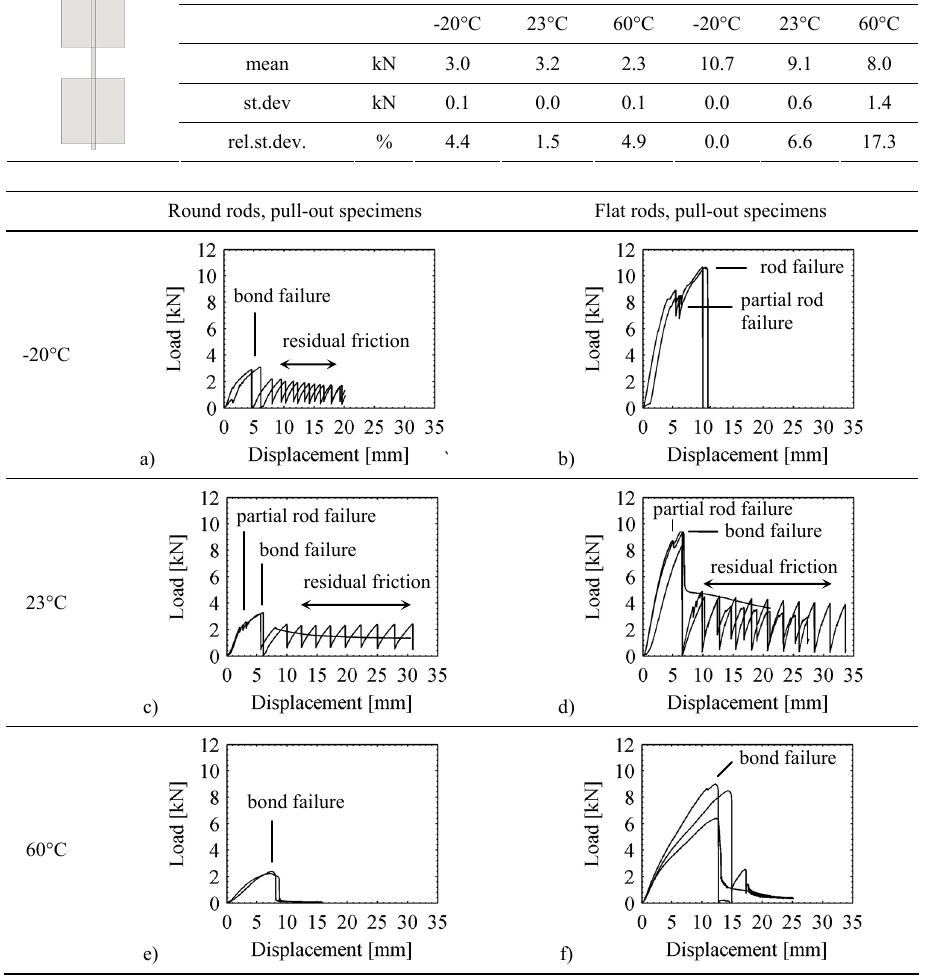
Figure 3: Load-displacement diagrams of the pull-out